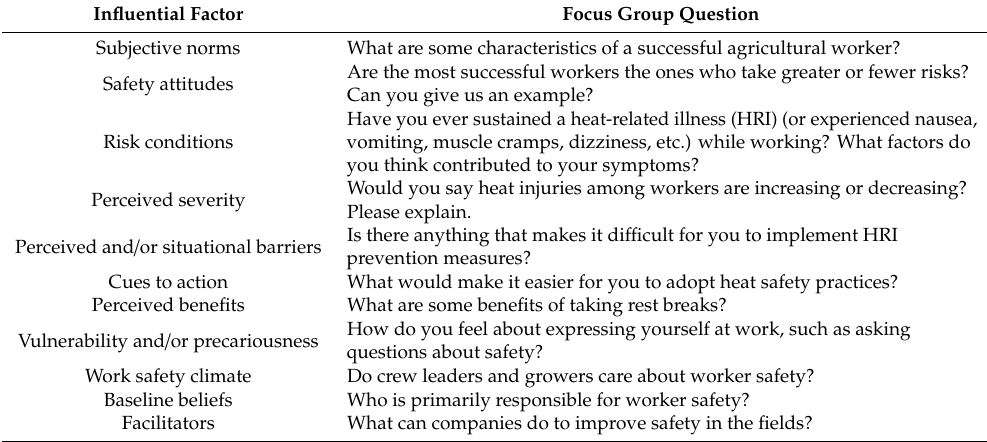
Table 1. Focus group guide used in discussions with Florida citrus